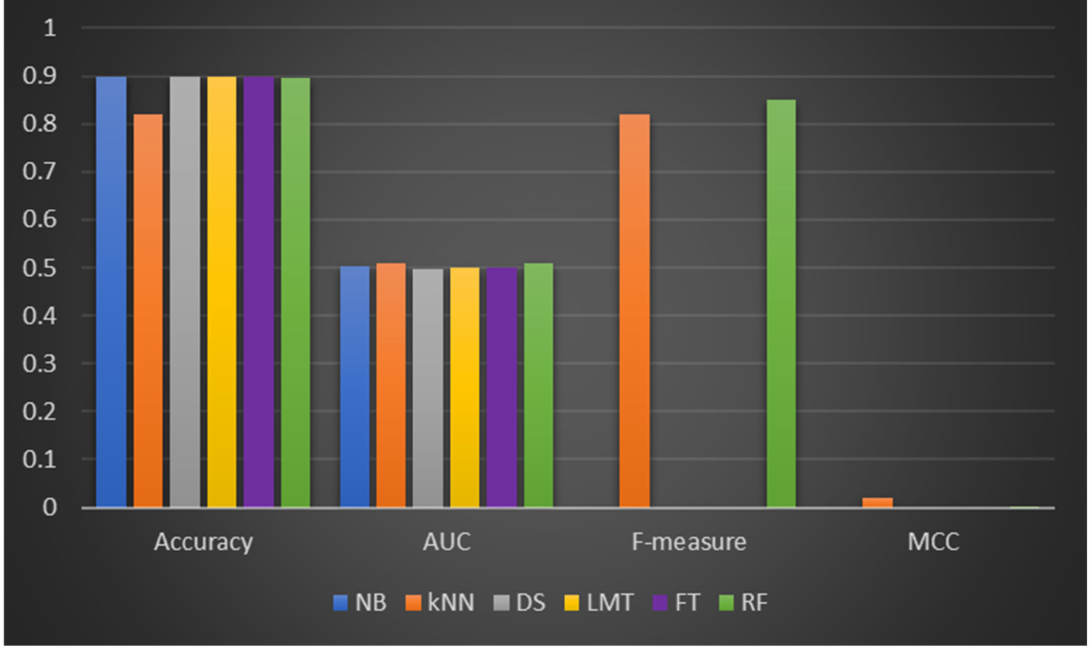
Figure 3. CCP Performance of DF models and ML Classifiers on Dataset